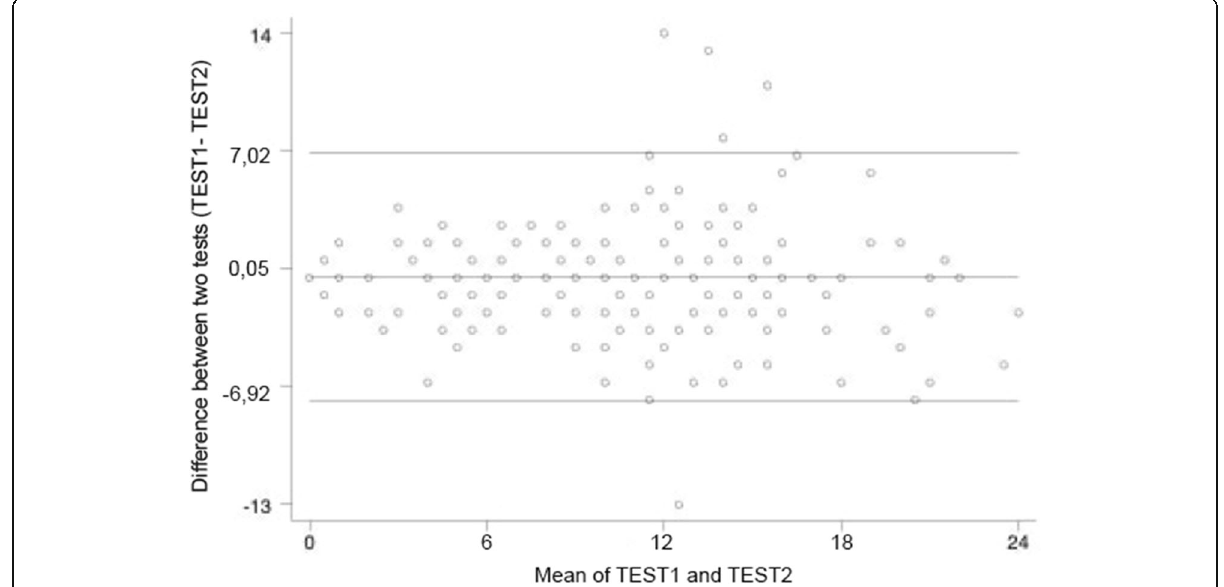
Fig. 2 Bland-Altman plot of test-retest reliability of the Insomnia Severity Index Danish